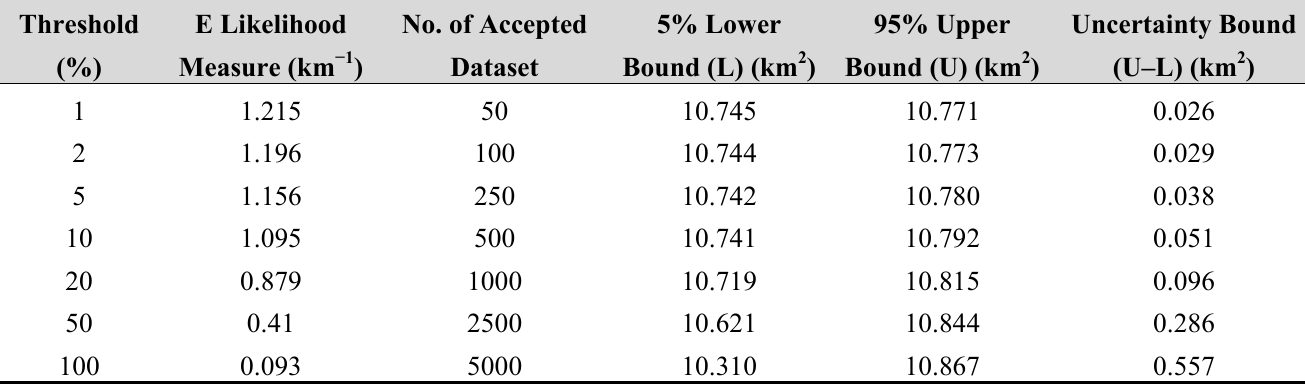
Table 5. E likelihood measure values, the number of datasets and the uncertainty bounds corresponding to the